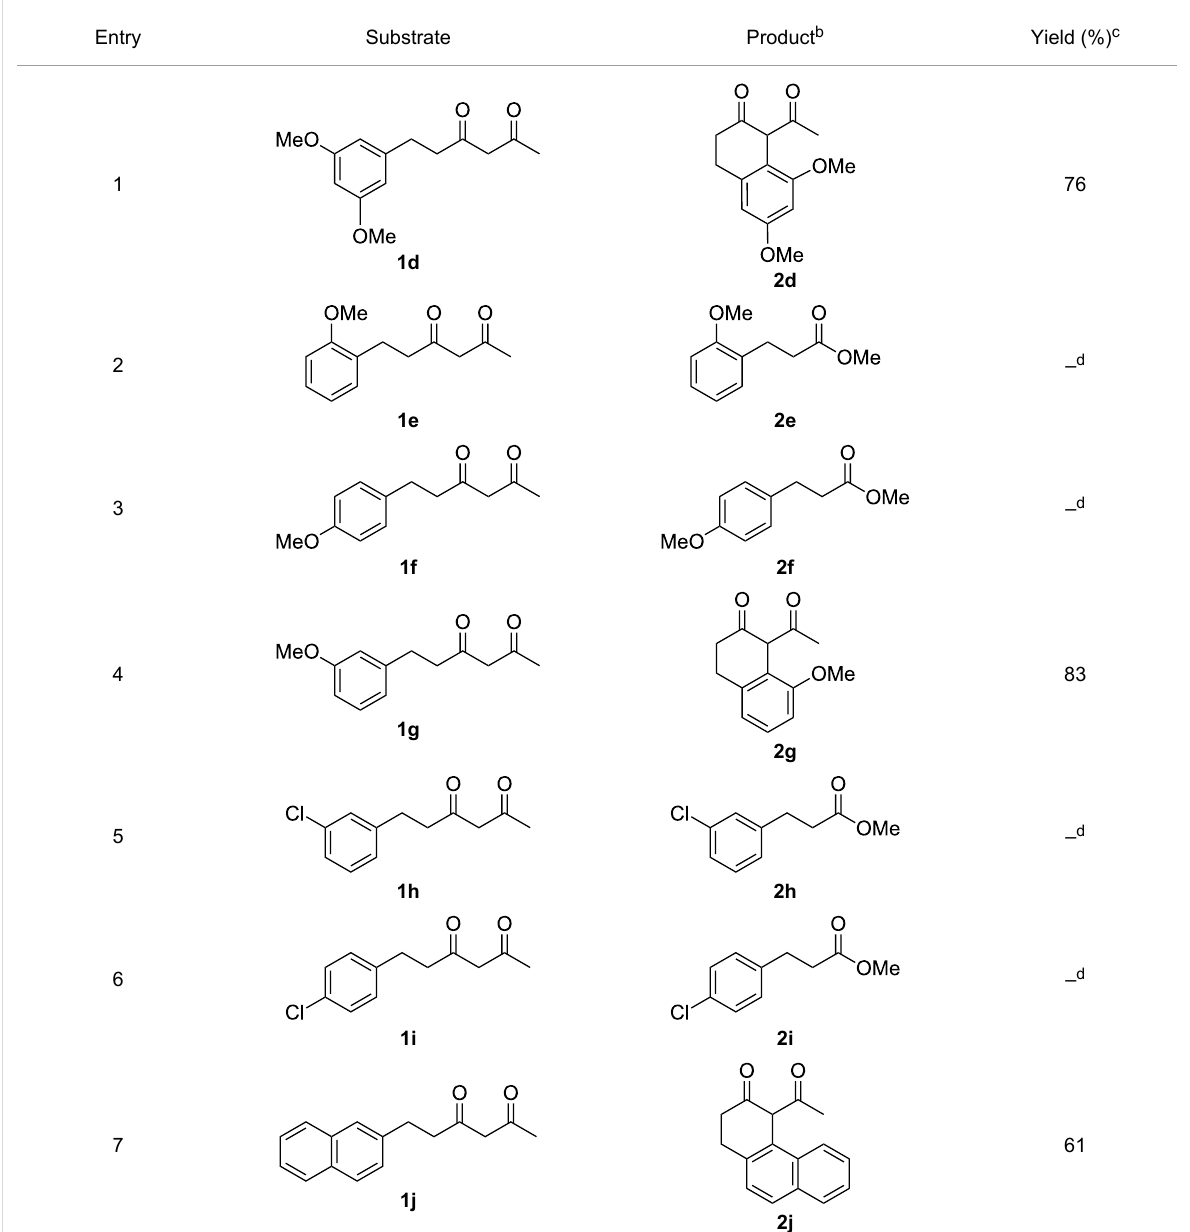
Table 2: Impact of ring substituents on the CAN-mediated oxidation of δ -aryl- β -dicarbonyl compounds in MeOH a